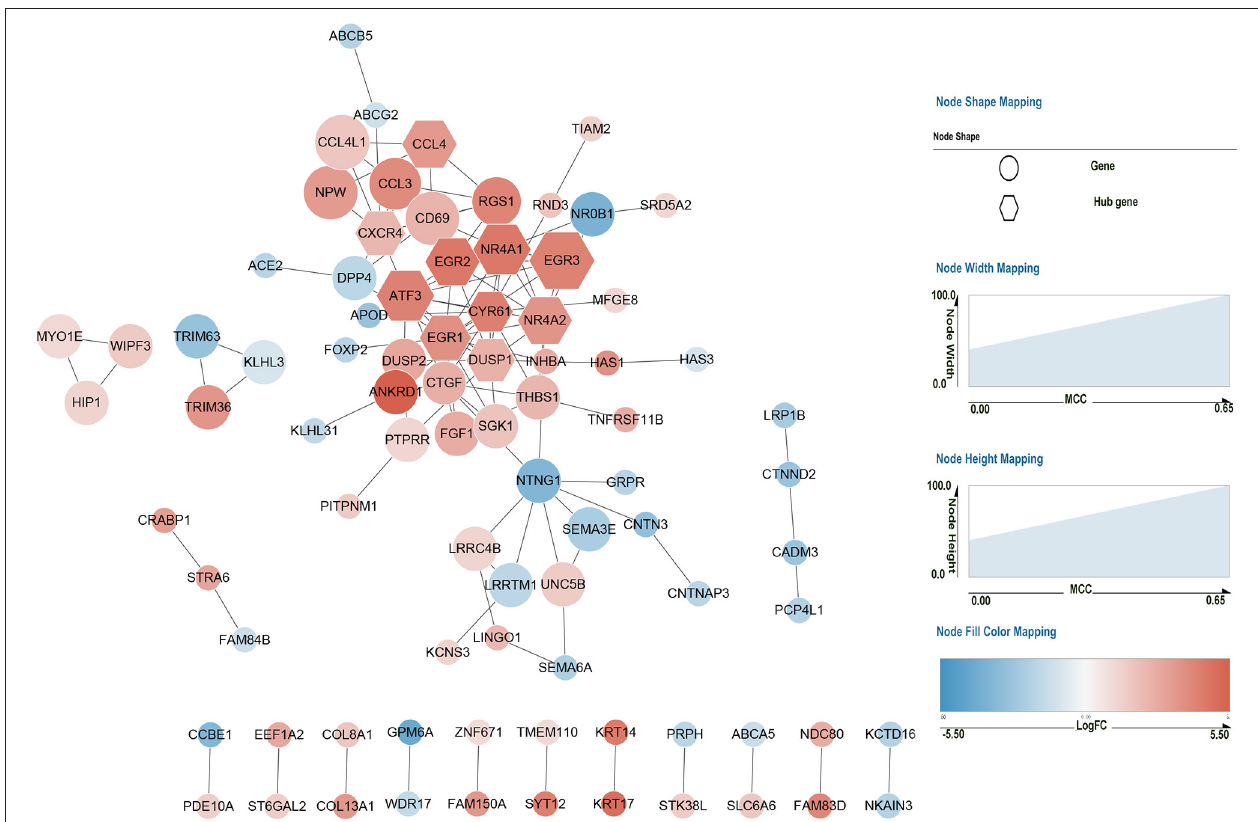
FIGURE 4 | Protein–protein interaction network of 185 DEGs. Red nodes represent the upregulated genes (log 2 FC > 1) in the AV fistula group compared with the control group, and blue nodes represent the downregulated genes (log 2 FC < − 1) in the AV fistula group compared with the control group. The nodes represent proteins. Each line between nodes represents the interaction relationship between two nodes. The size (i.e., width and height) of each node represents the rank score calculated by the MCC method in Cytoscape software. The color depth represents the value of log 2 FC; the bluer the color, the lower the log 2 FC value; and the redder the color, the larger the log 2 FC value. The hexagonal nodes represent the identified hub gene, and the circular nodes represent the DEGs except the hub genes. FC, fold change; MCC, Maximal Clique Centrality.